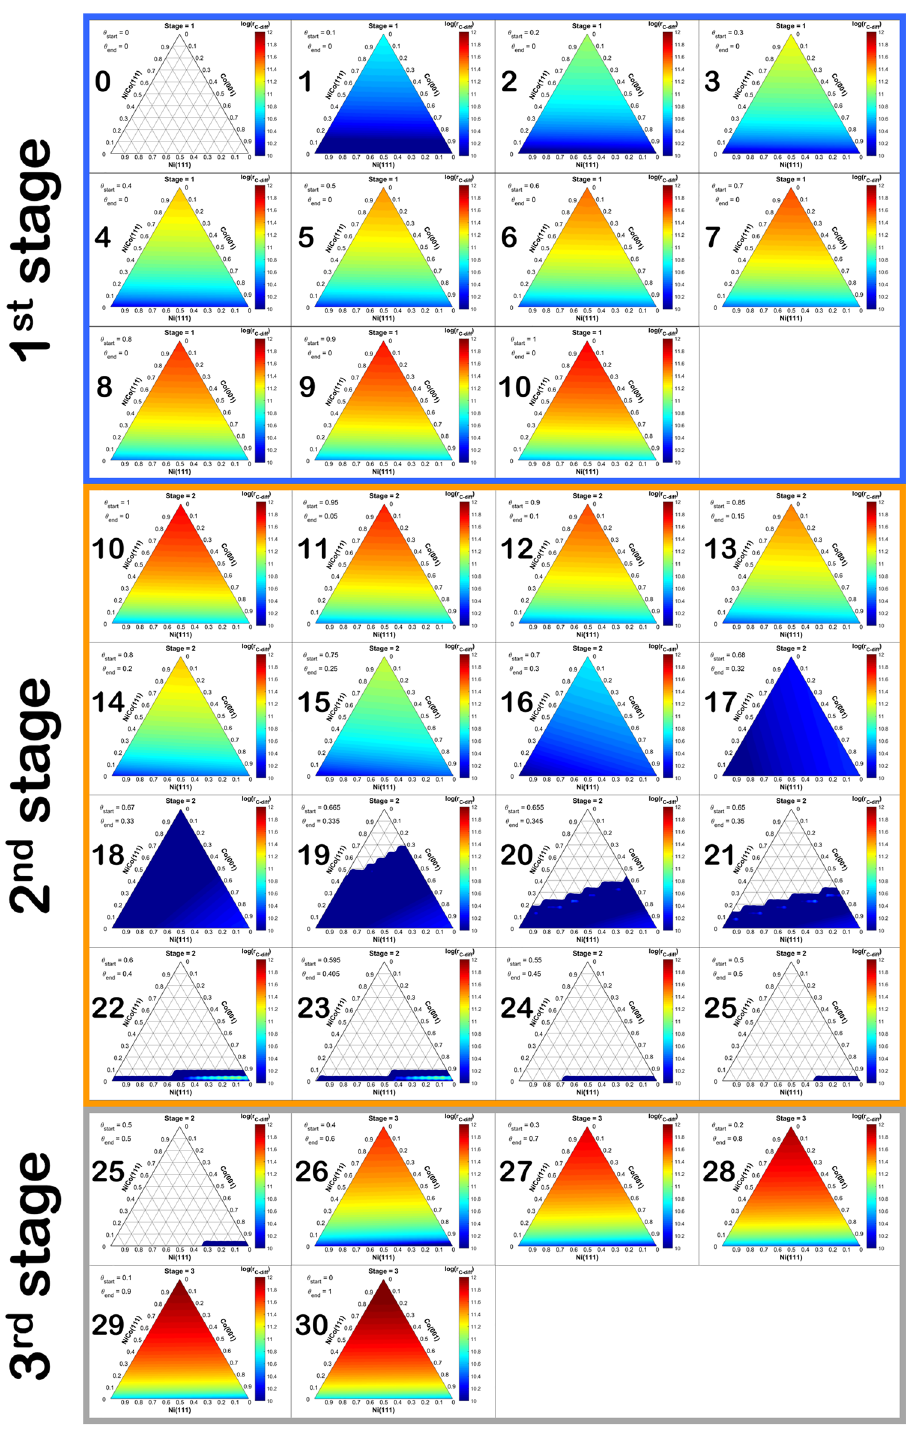
Figure 15. Ternary contour plot (TCP) of log rate of C diffusion as a function of the surface composition comprises of Ni111, Co111, and NiCo111 during the 1st (frame 0–10), 2nd (frame 10–25), and 3rd (frame 25–30) stage carbon diffusion, where each TCP corresponds to the reaction coordinate in Fig. 13. Note that the rate of diffusion in the 3rd stage is the rate of the back-diffusion; thus, the direction of diffusion is from the terminal site to the initial site. Besides, all TCP are shown individually in the Supplementary document in Figs.